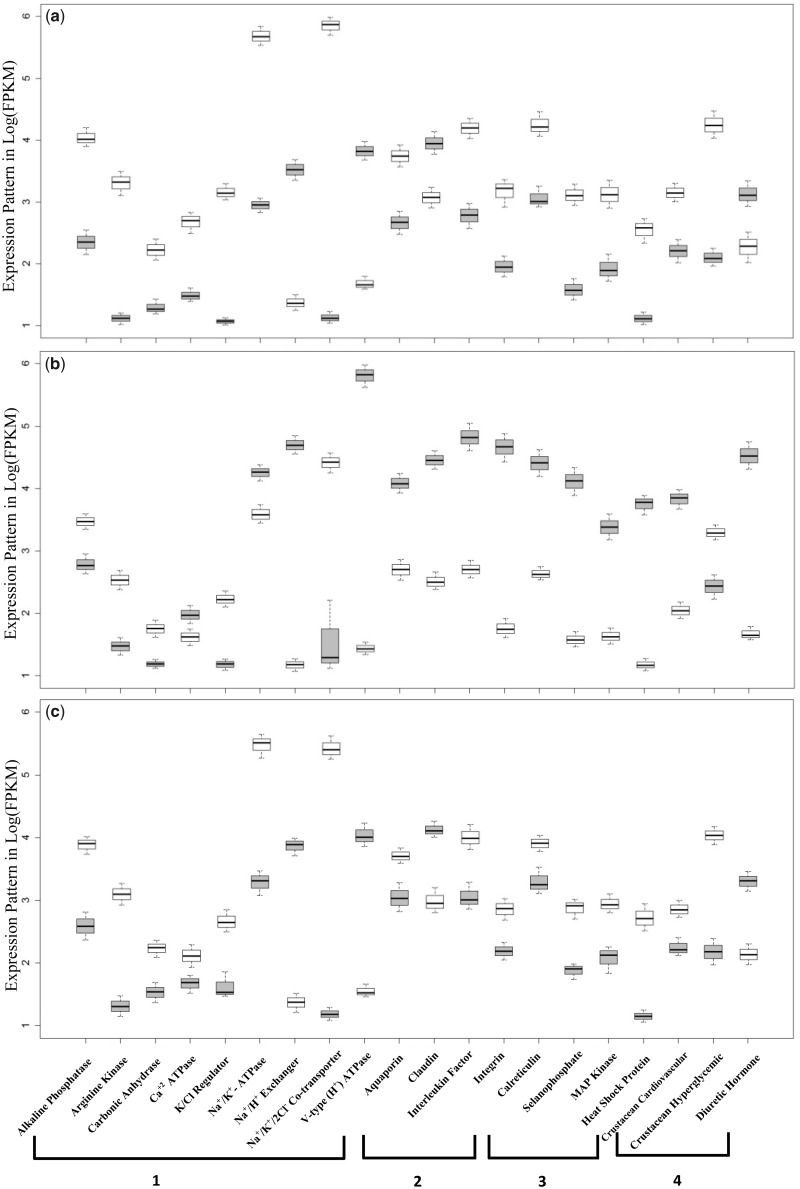
—Box and Whisker plots showing differential expression pattern (in log[FPKM]) of some (top 20) preidentified genes at 0‰ (gray boxes) and 15‰ (white boxes): (a) Macrobrachium australiense, (b) Macrobrachium novaehollandiae, and (c) Macrobrachium tolmerum. Candidate genes on the x axis are grouped by functional role as 1 = osmoregulatory genes; 2 = cell volume and cellular junction maintaining genes; 3 = stress response genes; and 4 = body fluid (hemolymph) regulating genes.